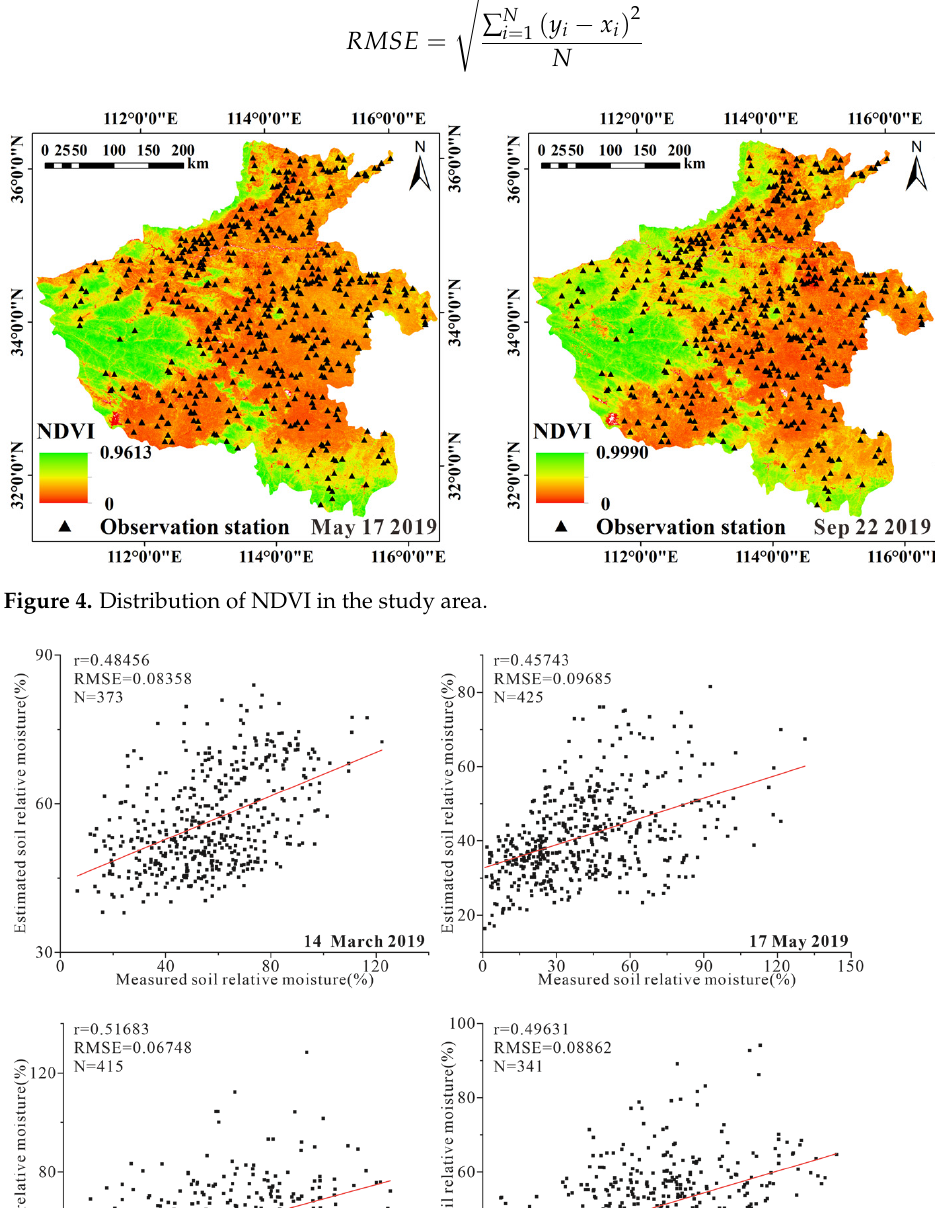
Figure 4. Distribution of NDVI in the study area.